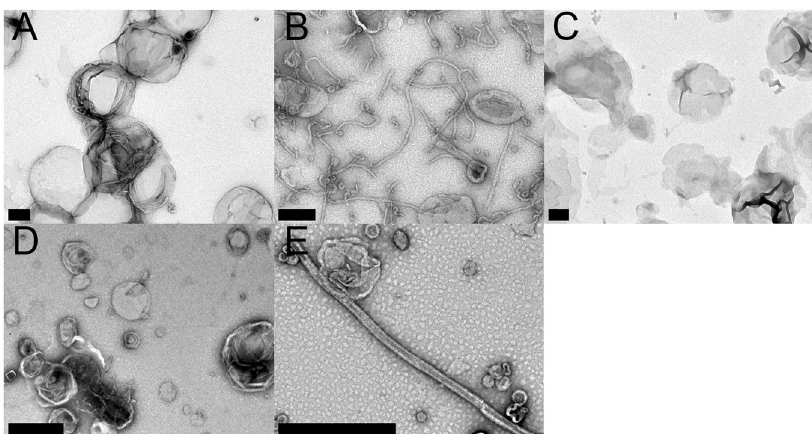
Fig. 6 Acetylation and acetylation-mimicking mutations inhibit Amphiphysin membrane remodeling. A – E TEM of liposomes incubated in the absence of protein ( A ), or with Amph-WT ( B ), Amph-acK15 ( C ), Amph-5Q15Q ( D ), or Amph-5R15R ( E ). Micrographs were repeated three times each in three independent assays. Scale bar = 200 nm.